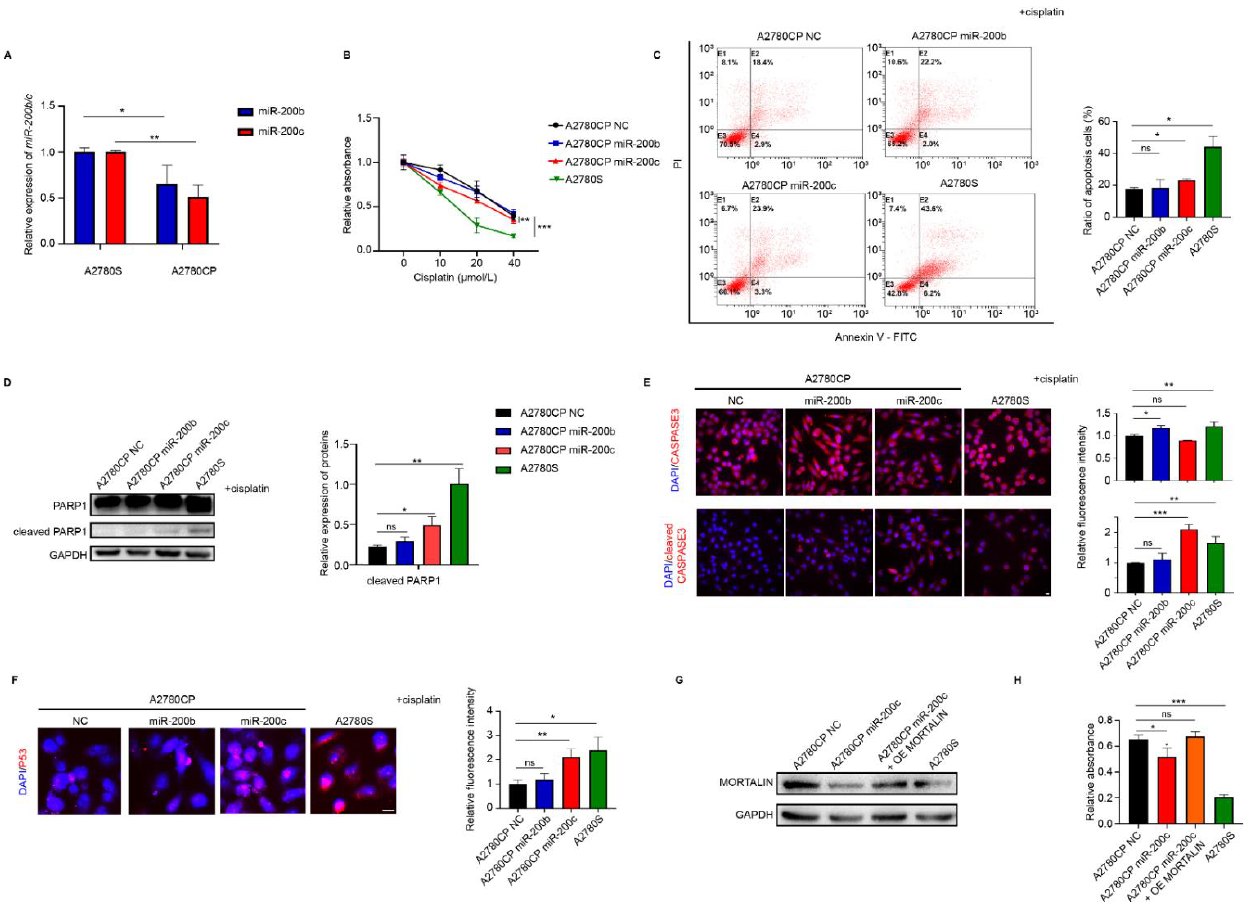
Figure 3. miR-200c increases cisplatin sensitivity of ovarian cancer cells. ( A ) Transcript levels of miR-200b/c in A2780S and A2780CP cells were determined via qPCR. Ovarian cancer cells were treated with different concentrations of cisplatin after transfection of A2780CP cells with miR-200b/c mimic or NC for 24 h. ( B ) Cell viability was determined via CCK-8 assay. ( C ) The levels of apoptosis markers, annexin V and propidium iodide (PI), were determined by measuring the mean fluorescence intensity using flow cytometry. ( D ) Expression levels of apoptosis-related proteins, PARP-1, and cleaved PARP-1, were determined via Western blotting. ( E ) Immunofluorescence assay to determine the expression of caspase-3 and cleaved caspase- 3 (red fluorescence), and 4′,6 -diamidino-2-phenylindole (DAPI; blue fluorescence) to determine the location of nucleus (scale bar, 10 μm). ( F ) Immunofluorescence assay to determine the expression of p53 (red fluorescence) and its translocation into the nucleus, and DAPI to determine its location in the nucleus (scale bar, 10 μm). ( G ) West- ern blotting showing the protein expression levels of mortalin in A2780CP cells after transfection of miR-200c mimic alone or co-transfection with miR-200c mimic and mortalin overexpression plas- mid. ( H ) After transfection for 24 h, cells were treated with 20 μM cisplatin for 24 h. Additionally, cell viability was determined via CCK-8 assay. Biological replicates (n = 3). * p < 0.05, ** p < 0.01, *** p < 0.001, ns p > 0.05.